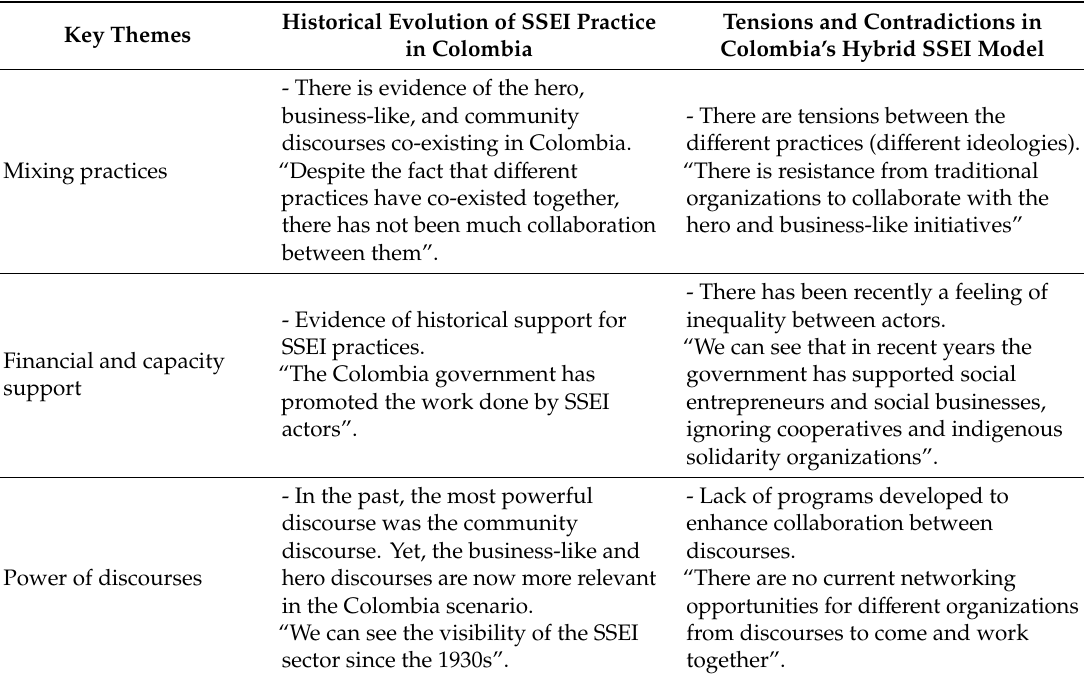
Table 3. Key themes identified within the